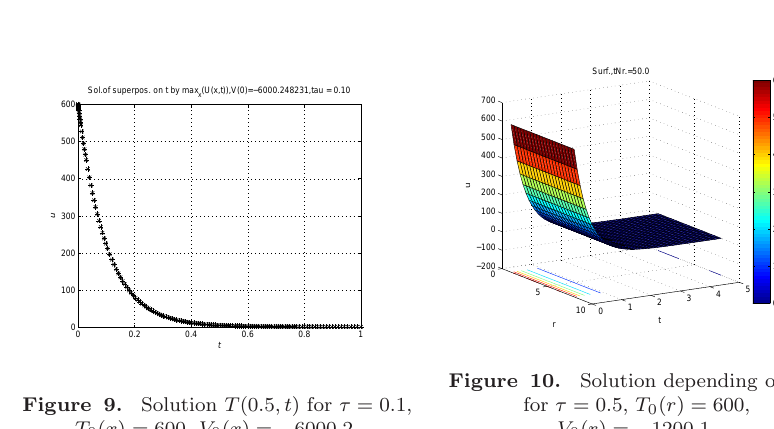
Figure 8. Solution T ( x, 0 . 2) with FDSES, N = 200.